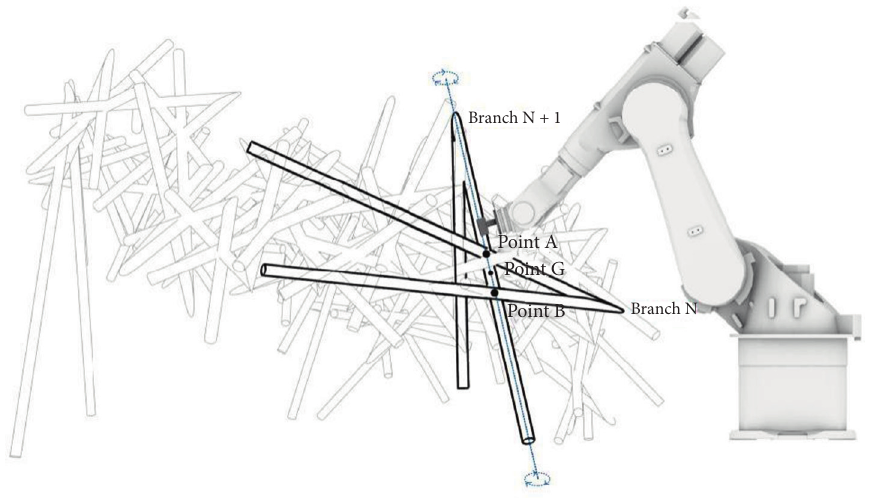
Figure 15: Branch